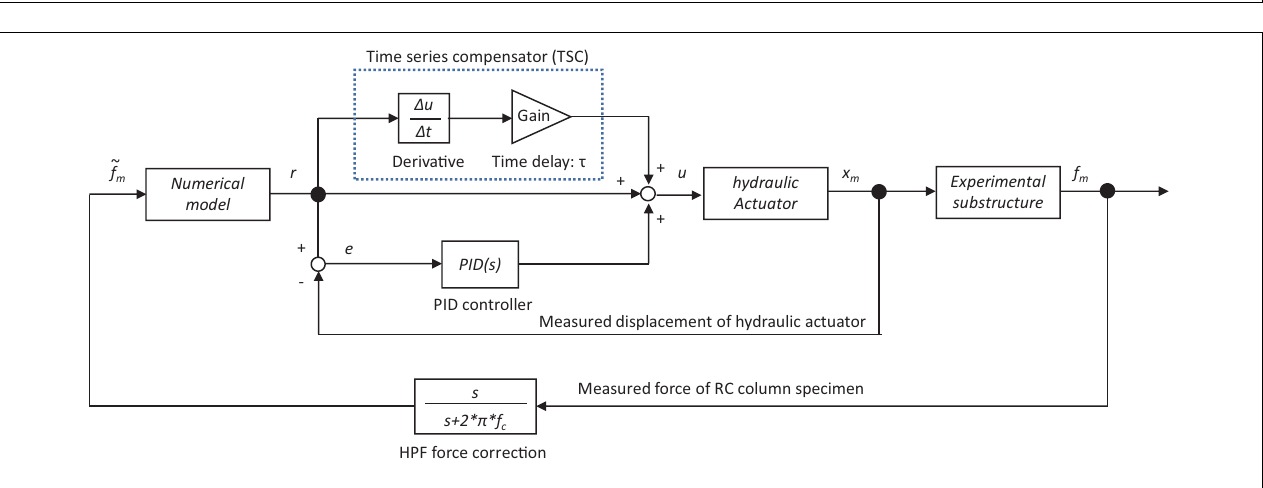
FIGURE 6 | Block diagram of actuator motion compensator and force correction.